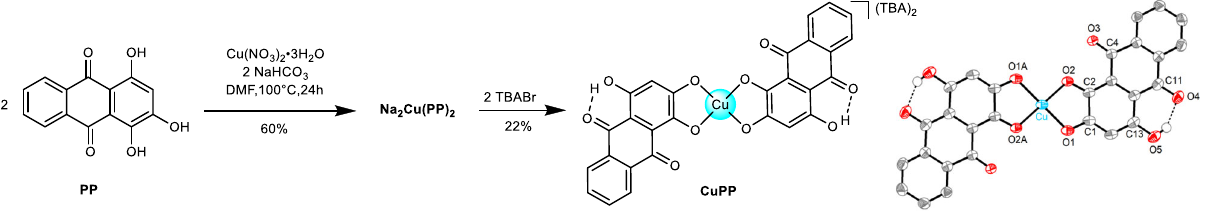
Fig. 2 Synthetic route for Cu purpurin complexes and crystal structure of CuPP. Thermal ellipsoids are shown at the 50% probability level. Parts of hydrogen atoms and TBA cations are not shown for clarity.